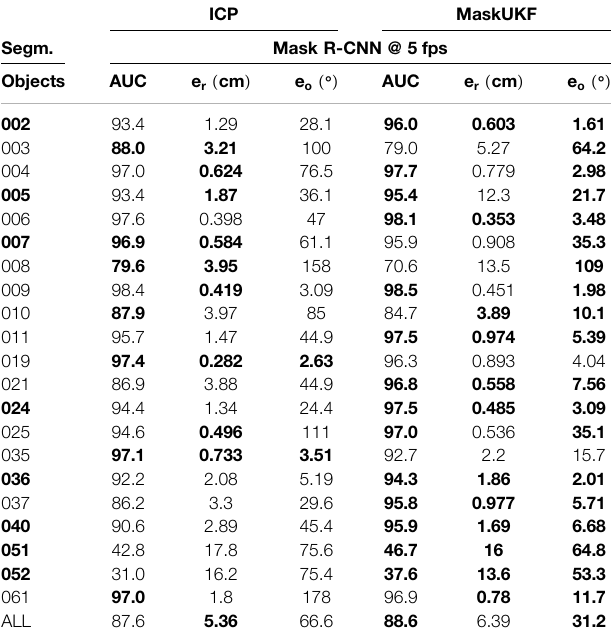
TABLE 4 | Quantitative evaluation of 6D pose on multi-rate scenario using YCB- Video Dataset (ADD-S (AUC), RMSE). Objects in bold are considered symmetric. A bold entry indicates a strictly better result (i.e. if different algorithms have the same best result, the associated entries are not bolded). ICP MaskUKF